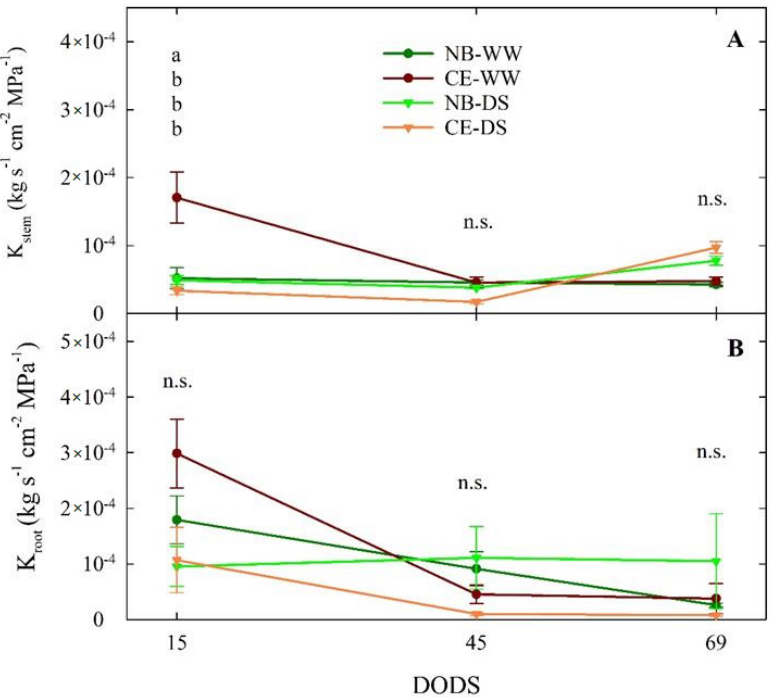
Figure 6. Stem sapwood−specific hydraulic conductance (K stem , A ) and root sapwood-specific hydraulic conductance (K root , B ) measured at 15, 45, and 69 days of drought stress (DODS) in well-watered and drought-stressed ‘Nocellara del Belice’ (NB-WW and NB-DS, respectively) and ‘Cerasuola’ (CE-WW and CE-DS, respectively) olive trees. Error bars indicate the standard errors of the means. For each day, different letters indicate significant differences between treatments according to the Tukey’s test following analysis of variance ( p < 0.05).